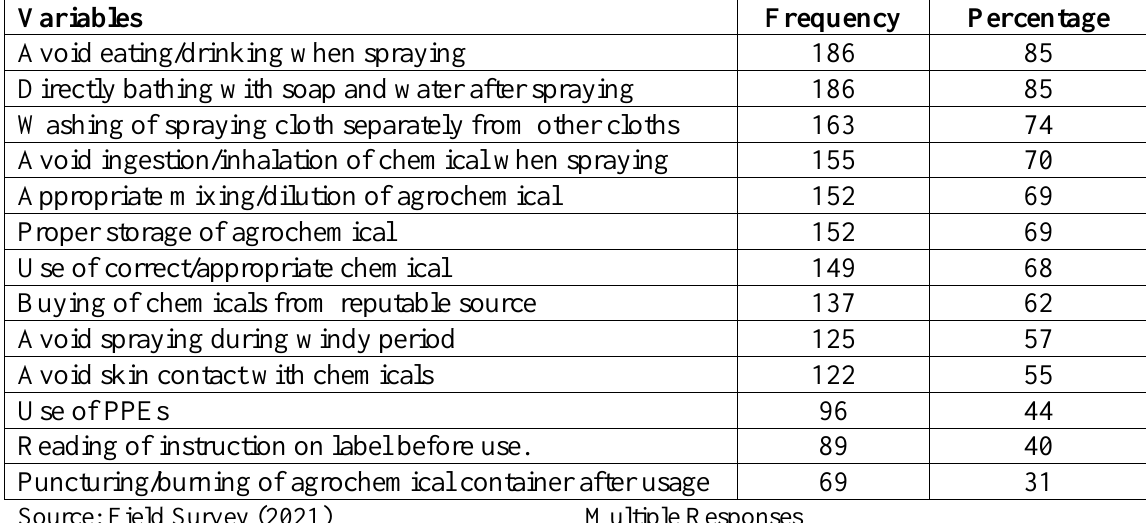
Table 3. Distributions of respondents based on awareness of agrochemical safety measures Variables